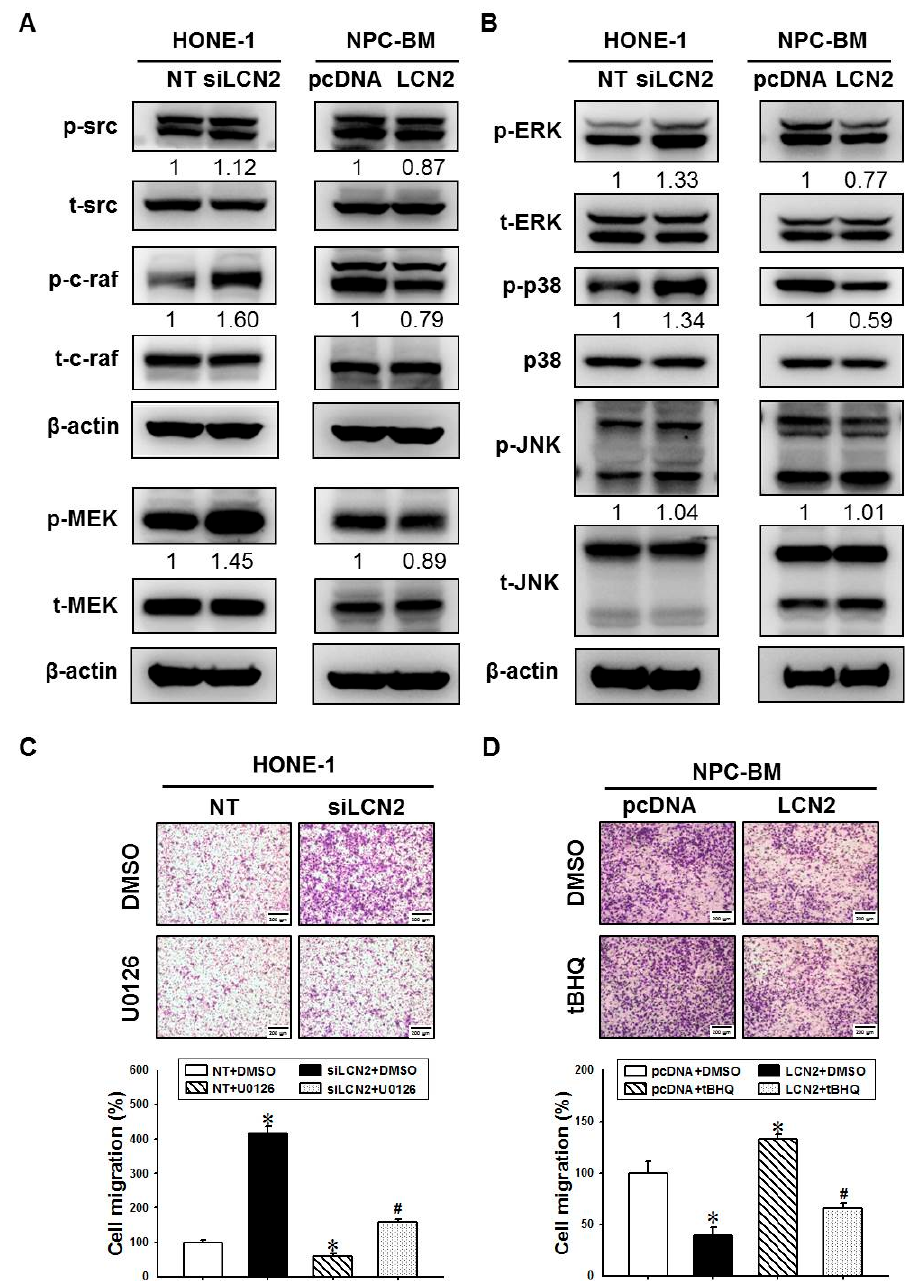
Figure 3. LCN2 suppressed the migration-associated signal cascades to modulate cell migration in human NPC cells. ( A , B ) The HONE-1 cells were transfected with siRNA against LCN2 (siLCN2) or control (NT) (left panel). The NPC-BM cells were transfected with control plasmids (pcDNA) or plasmids containing LCN2 (LCN2) (right panel). The migration-associated signal proteins, including their phosphorylation levels, were examined using Western blot analyses. ( C ) The HONE-1 cells that were transfected with siLCN2 or NT and then treated with the MEK/ERK inhibitor, U0126. After treatment, these cells were subjected to cell migration analysis. ( D ) The NPC-BM cells that were transfected with pcDNA or LCN2 plasmids and then treated with the ERK activator, tBHQ. After treatment, these cells were subjected to cell migration analysis. * p < 0.05 compared with control. # p < 0.05 when compared with HONE-1 cells that were transfected with NT plus U0126, or NPC-BM cells that were transfected with pcDNA plus tph.